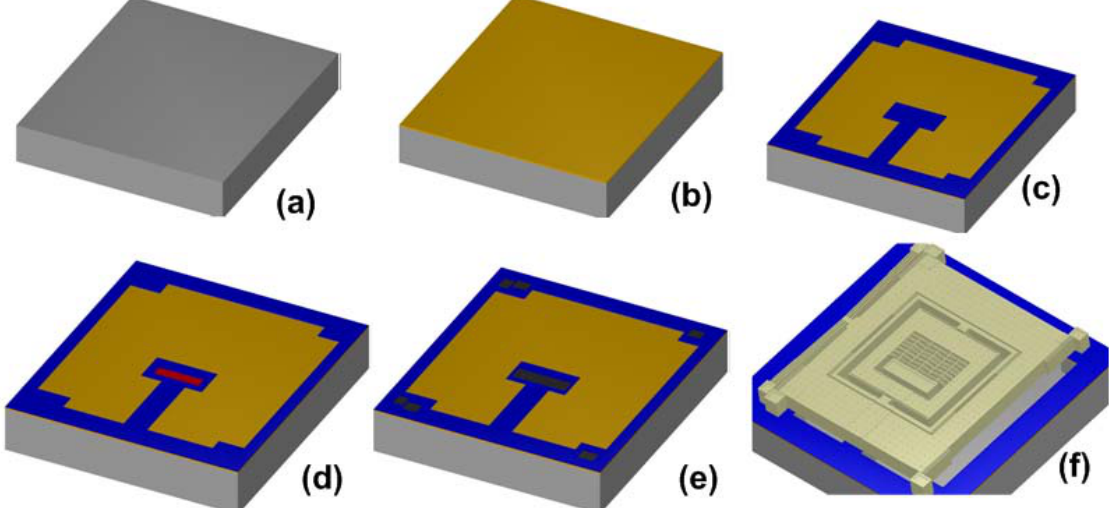
Figure 10. Process flow for the fabrication of microgyroscope using MetalMUMPs in MEMSPro (a) N-type (cid:1731)100(cid:1732) silicon wafer (b) 2 µm thick isolation oxide layer (c) patterning of 0.35 µm thick silicon nitride layers (d) patterning of 0.7 µm thick Polysilicon layer (e) patterning of anchor metal layer (f) patterning of 20 µm electroplated structural layer of Ni and trench etch in the